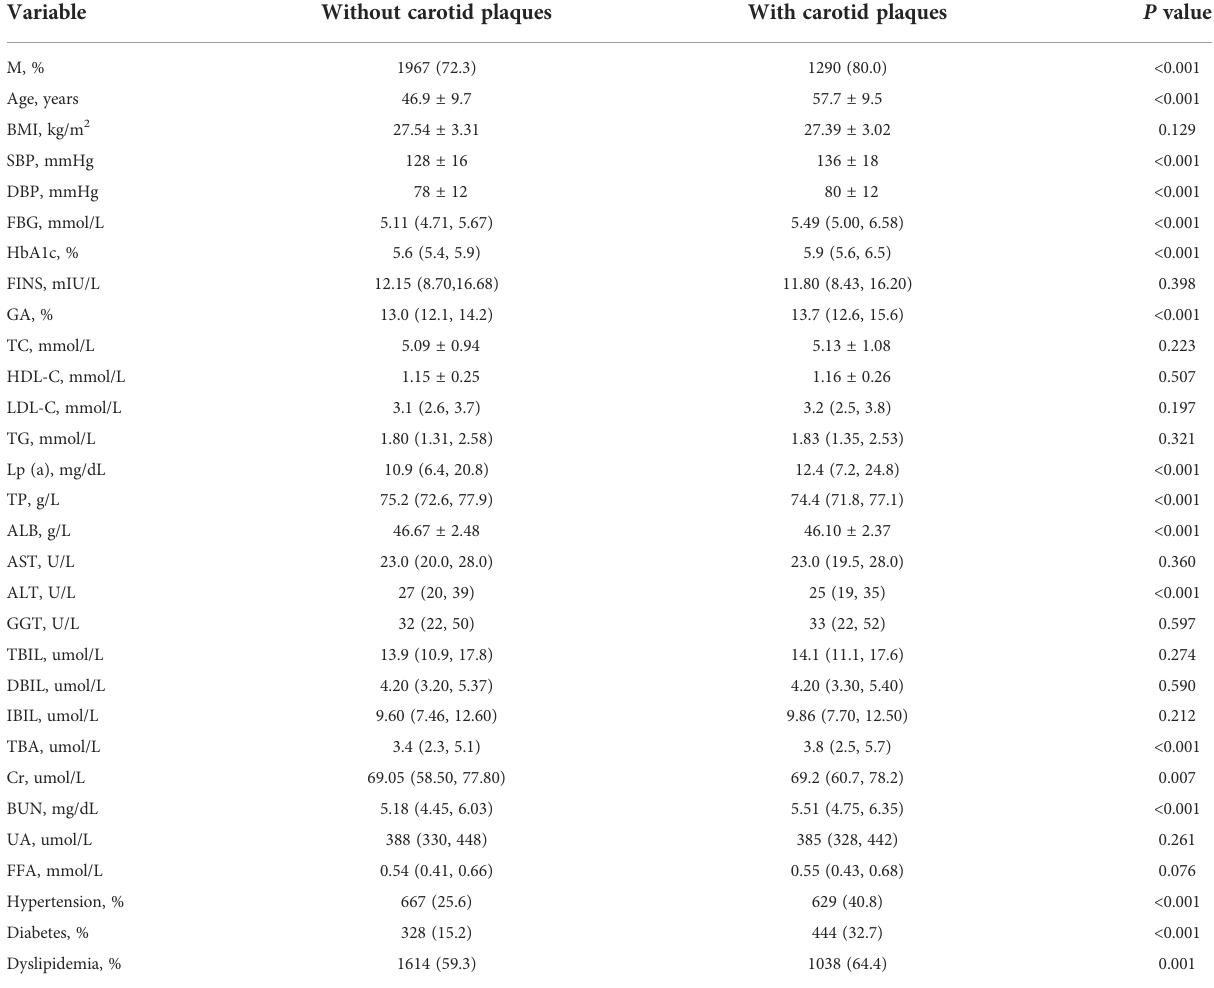
TABLE 1 Baseline characteristic of fatty liver patients with or without carotid plaques. Variable Without carotid